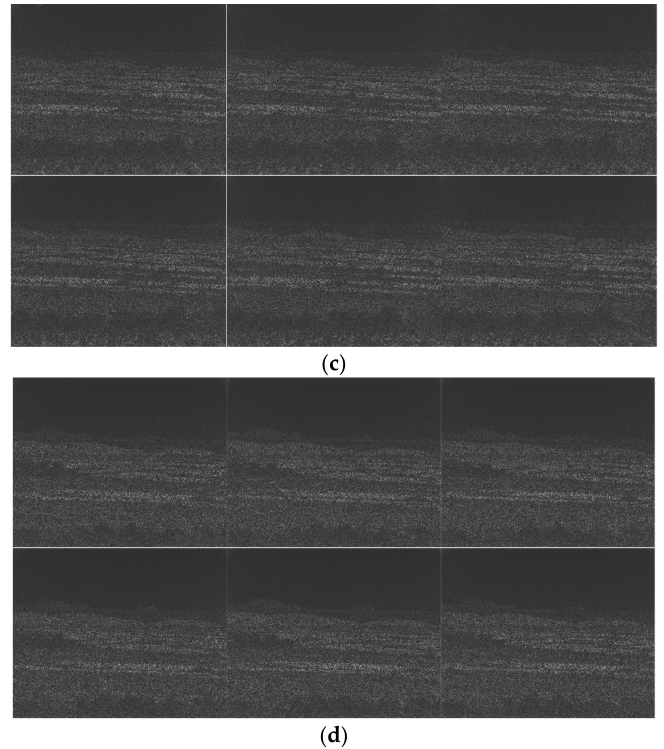
Figure A4. Tracking results for frames 1, 60, 119, 178, 237, and 296 for the PCE 25 (MWIR daytime) case. The vehicle is SUV. No detections can be seen in the sampled frames. ( a ) 1000 m; ( b ) 2000 m; ( c ) 2500 m; and ( d ) 3500 m.